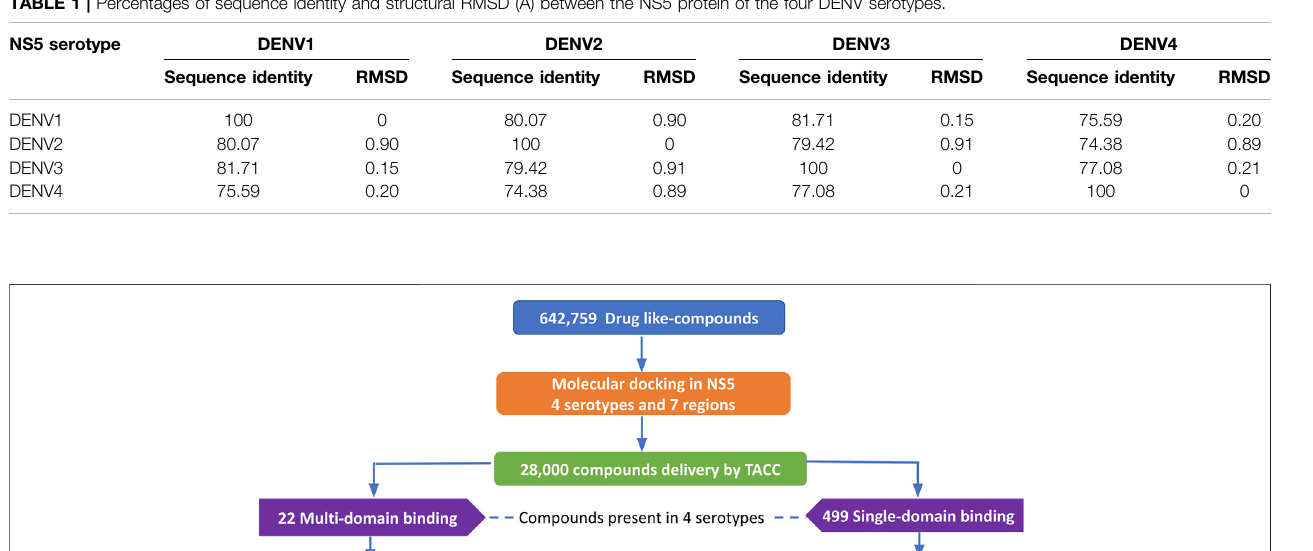
Frontiers in Chemistry |